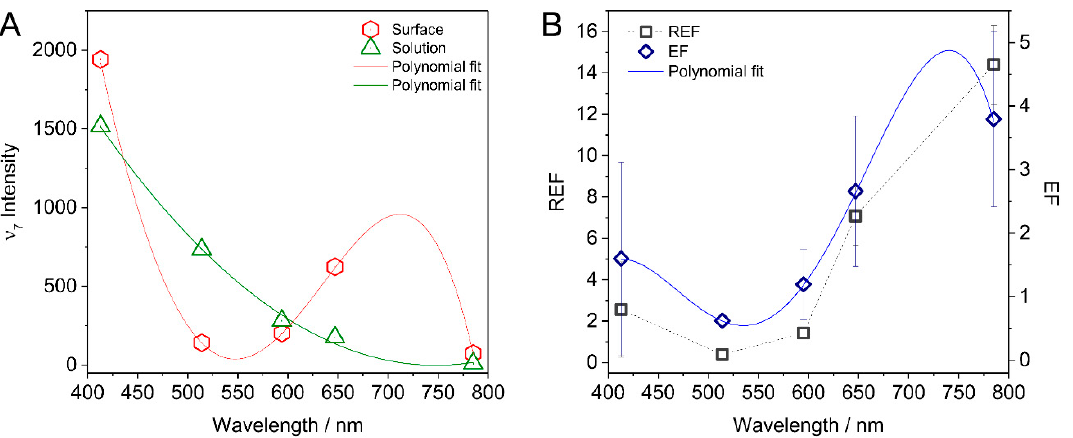
Figure 3. ( A ) Raman intensity of the ν 7 mode of AB in solution (green) and at the TiN surface (red) as a function of laser excitation wavelength. ( B ) Raman enhancement factor (REF) (blue) and enhancement factor (EF) (black) calculated from the data according to Equation (1) as a function of excitation wavelength. Lines correspond to polynomial fits to the data set.